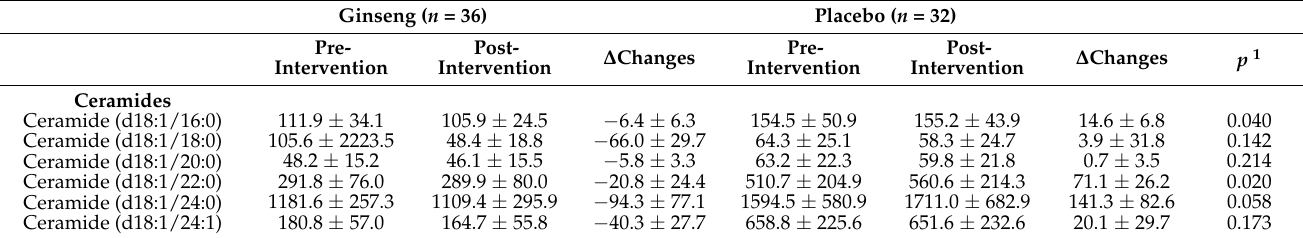
Subjects in the KRG-intervention group were then further analyzed, comparing those with metabolic syndrome to those without metabolic syndrome. The mean baseline serum levels of each plasma ceramide species in subjects with and without metabolic syndrome are plotted in Figure 1. The mean levels of C16 ceramide (d18:1/16:0), C20 ceramide (d18:1/20:0), and C22 ceramide (d18:1/22:0) were significantly higher in the metabolic syn- drome group than in the non-metabolic syndrome group before intervention